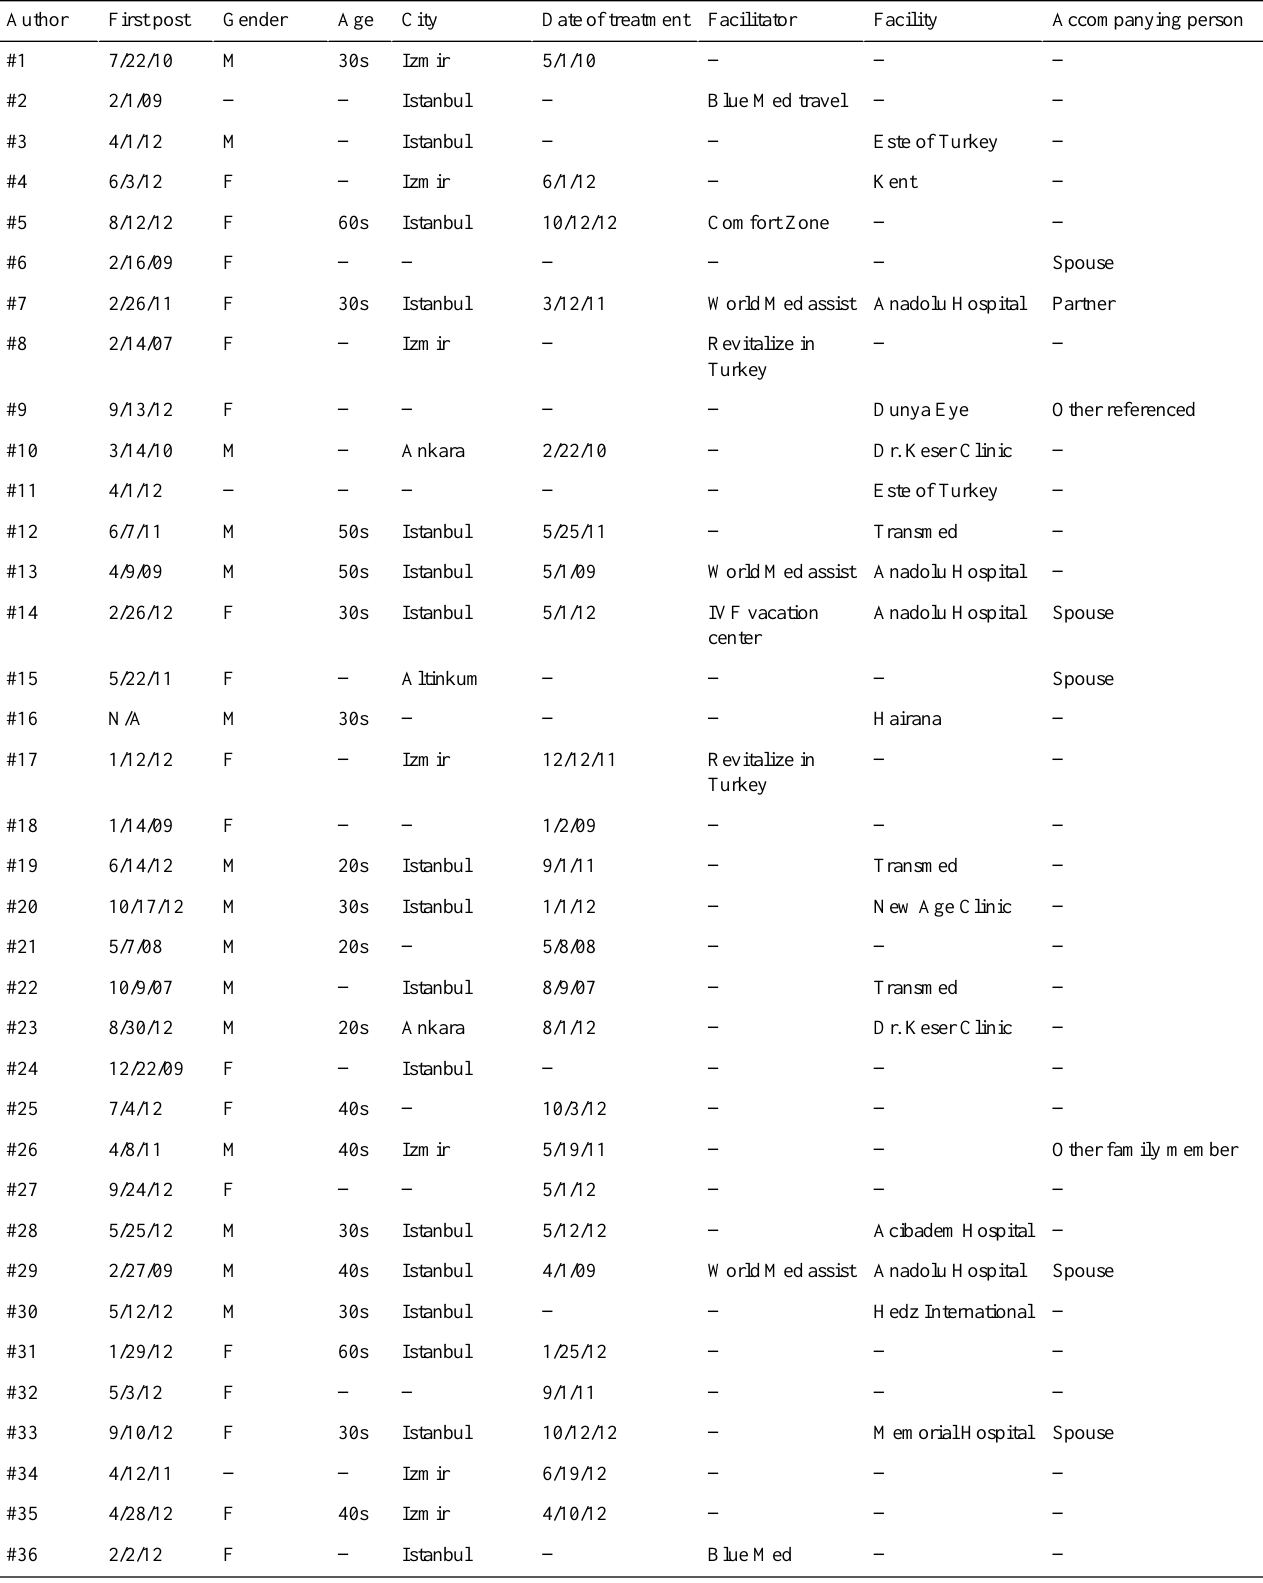
Table 3. Health travelers’date of initial narrative, demographics, location of treatment, date of treatment, facilitator facility, and accompanying